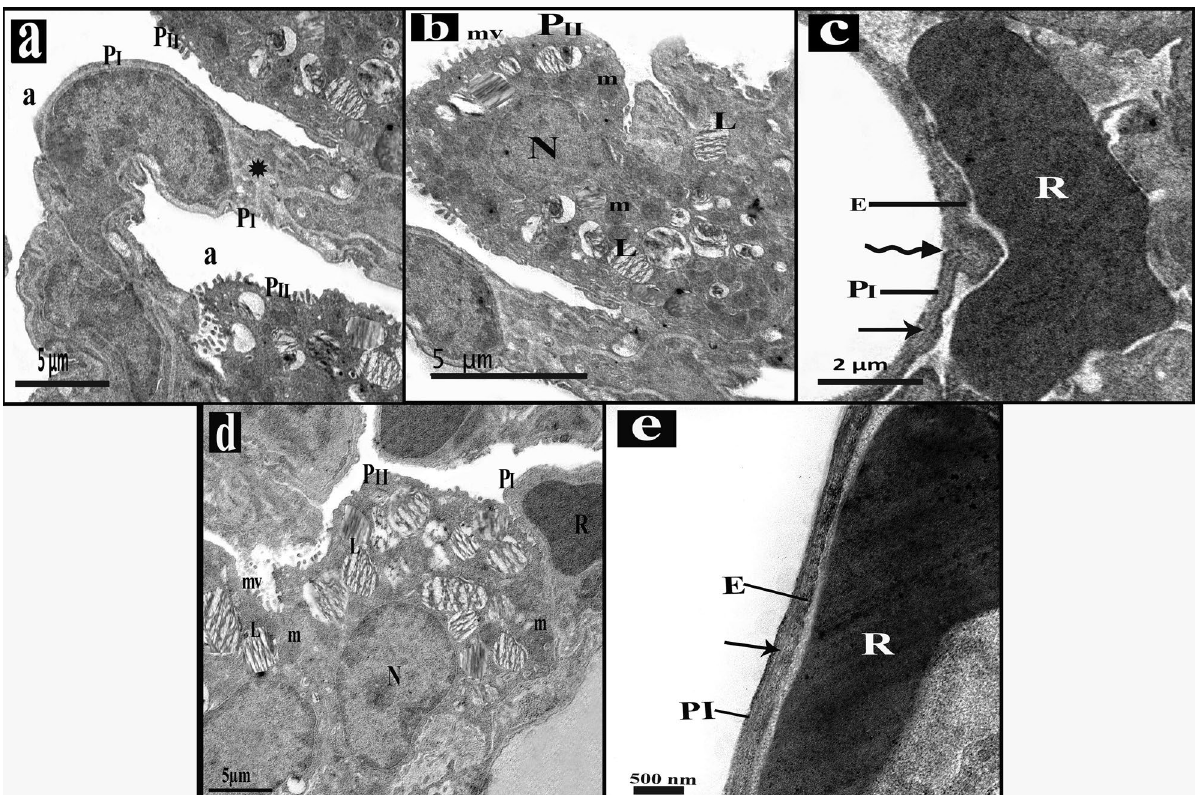
Figure 6. An electron micrograph of sections in lung of Mesna groups. (a–c) Mesna I group. ( a) alveoli (a) lined by type I (PI) and type II (PII) pneumocytes with thin interalveolar septa (*). ( b ) Type II pneumocytes (PII) has regular nucleus (N), lamellar bodies (L), mitochondria (m) and short microvilli (mv) bulge to the lumen. ( c) Blood air barrier appears regular except for small area (zigzag arrow). it’s composed of thin cytoplasm of type I (PI), the fused basal laminae (arrow), and endothelial cells (E). Notice RBCs (R) in the capillary lumen. (d,e) Mesna II group. ( d) Type I (PI) and type II (PII) pneumocytes appear lining the alveoli. Type II pneumocyte (PII) has regular nucleus (N), lamellar bodies (L), mitochondria (m) and short microvilli (mv) bulge to the lumen. notice the RBCs (R) within the lumen of the blood capillary. ( e) blood air barrier appears regular and composed of thin cytoplasm of type I (PI), the fused basal laminae (arrow), and endothelial cells (E). Notice RBCs (R) in the capillary lumen.